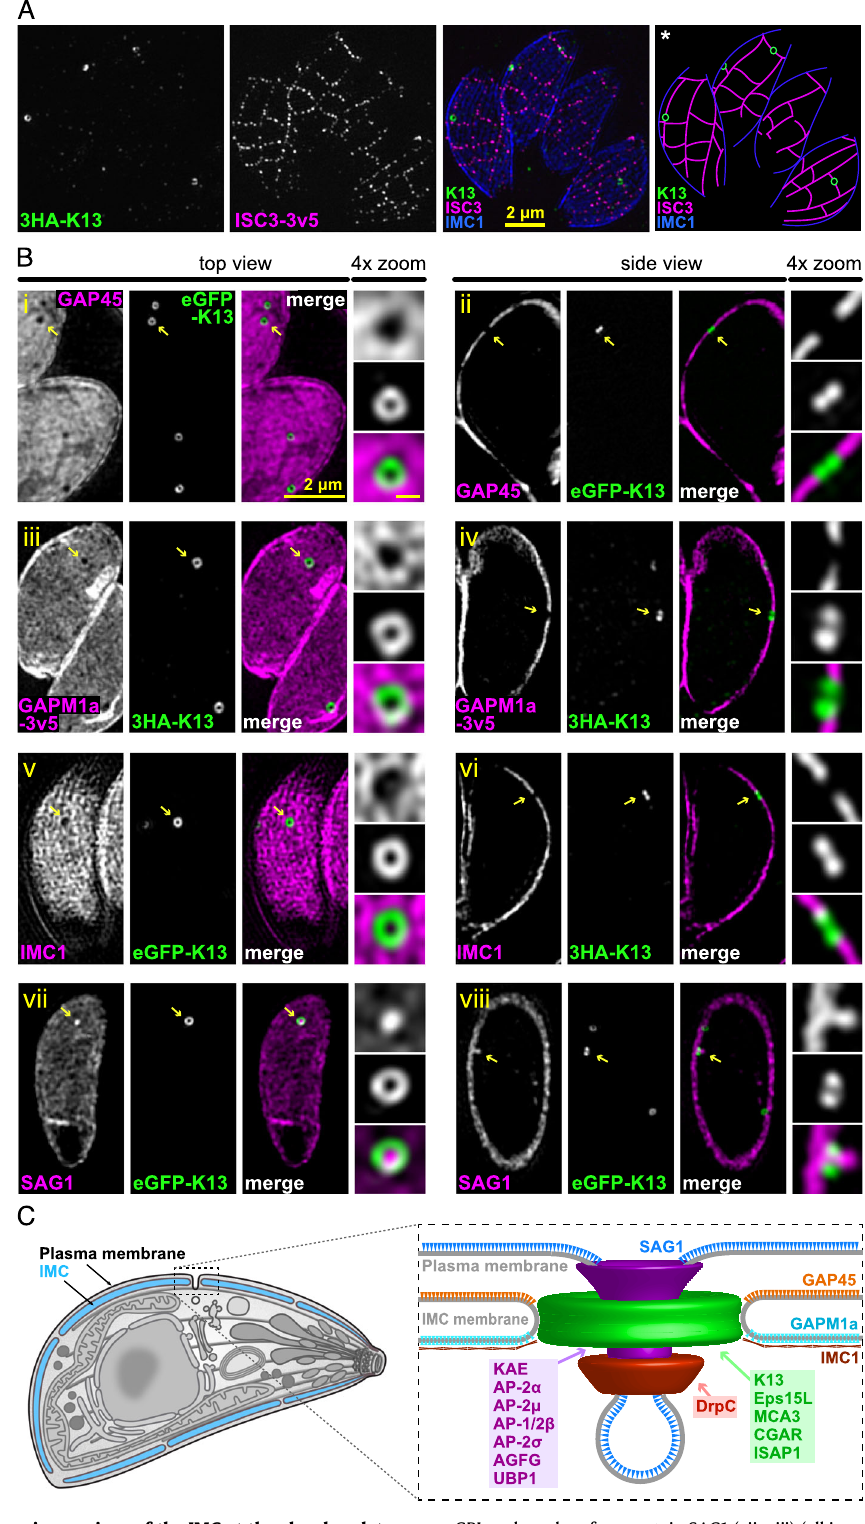
GPI-anchored surface protein SAG1 (vii – viii) (all in magenta). Yellow arrows corre- spond to structures shown in the magni fi ed panels, and all scale bars are 2 µ m and 0.2 µ mfortheoverviewandzoomedimages,respectively. C Modeloftheendocytic K13 micropore complex in the pellicle of T. gondii tachyzoite from these data and Figs. 1 and 2. IMC inner membrane complex. See Figs. S5 and S6 for further